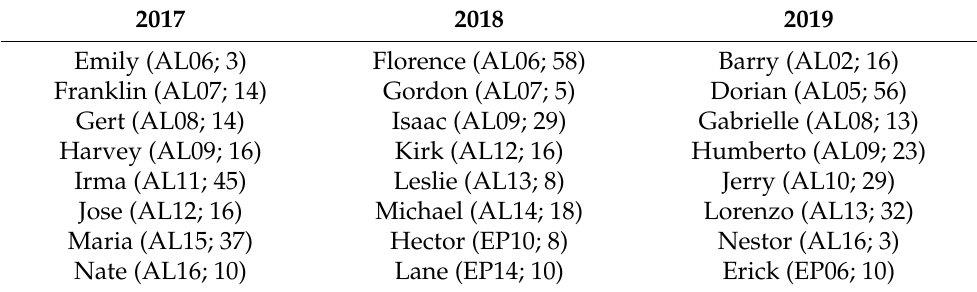
Table 1. TC cases used in this study. The values inside the parenthesis note the TC identification number, while the second is the number of initialization times for each storm (489 total initializa- tion